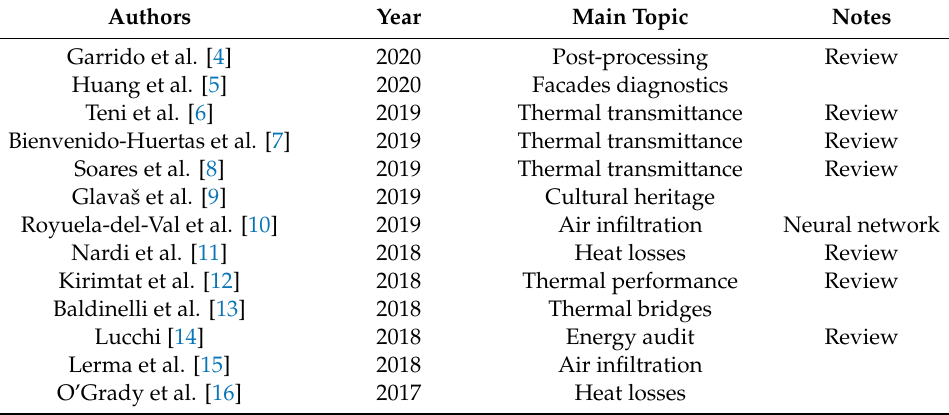
Table 1. A (not exhaustive) list of recent papers about infrared thermography (IRT) for